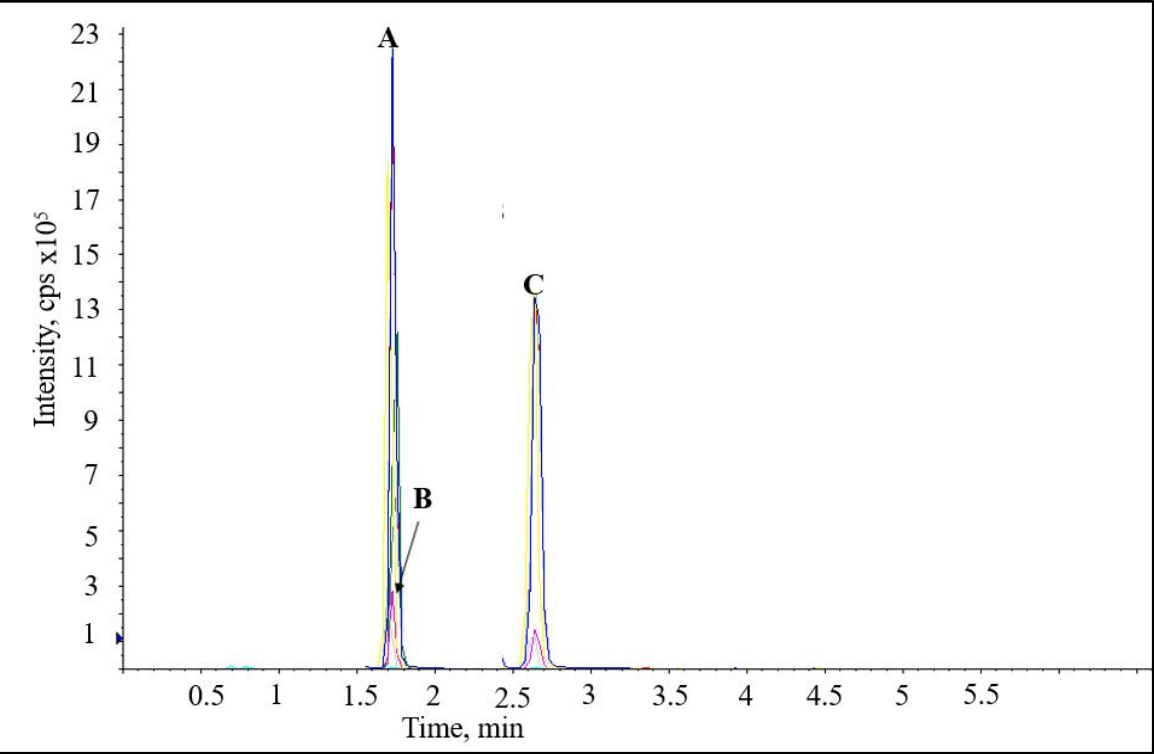
Figure 3. Liquid chromatography–tandem mass spectrometry (LC-MS/MS) chromatographic separation of 7-keto ( A ), 7-hydroxy ( B ), and 5, 6 epoxy ( C ) cholesterol using reverse-phase chromatography.